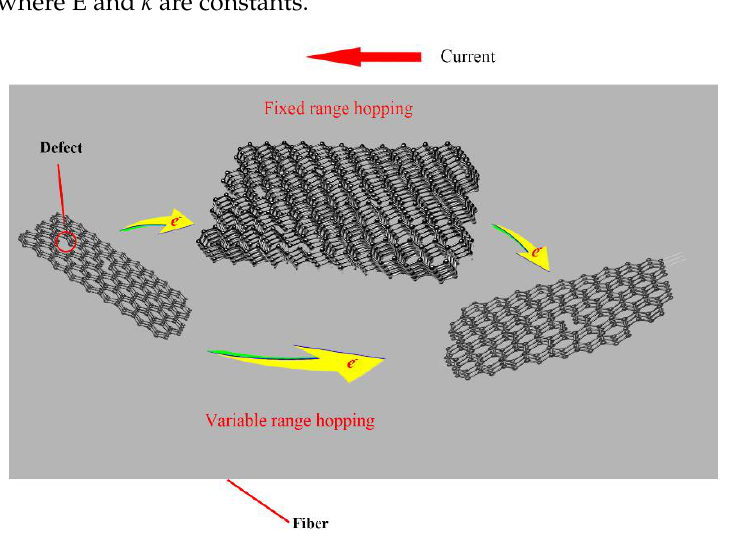
Figure 10. The electrical conduction mechanism in the samples.